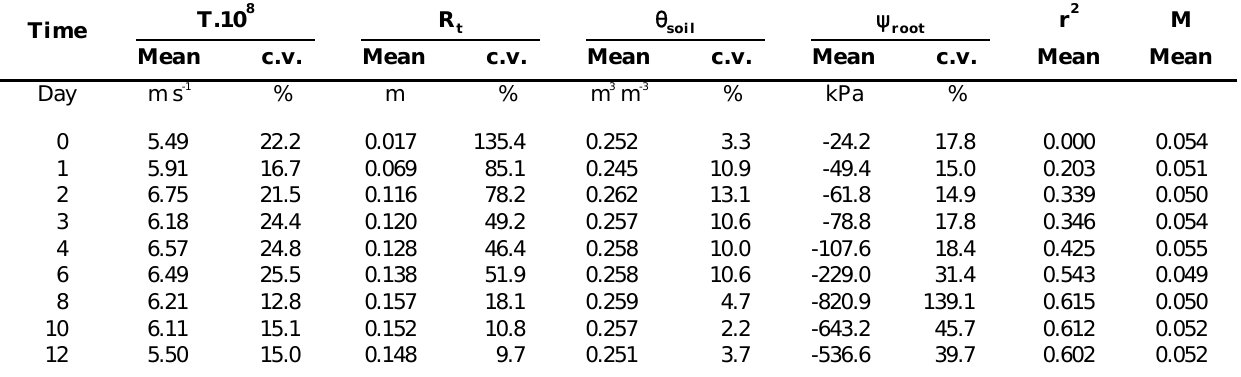
Table 1. Mean values of transpiration ( T ), advance of the drying front ( R t ), soil water content outside the